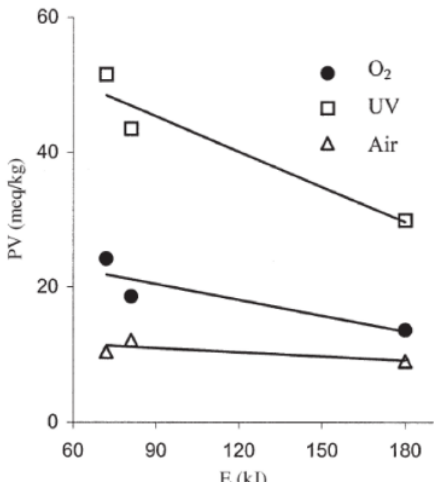
Figure 5. Peroxide values (PV) of emulsified extra virgin olive oil as function of mechanical energy supplied to make the emulsions. The symbols in the plot represent the oxidizing conditions. Reprinted from JAOCS, Vol 19, Issue 1. The role of water in the oxidation process of extra virgin olive oils, Pages No 577–582, Copyright (2002), with permission from Wiley and Sons [80].